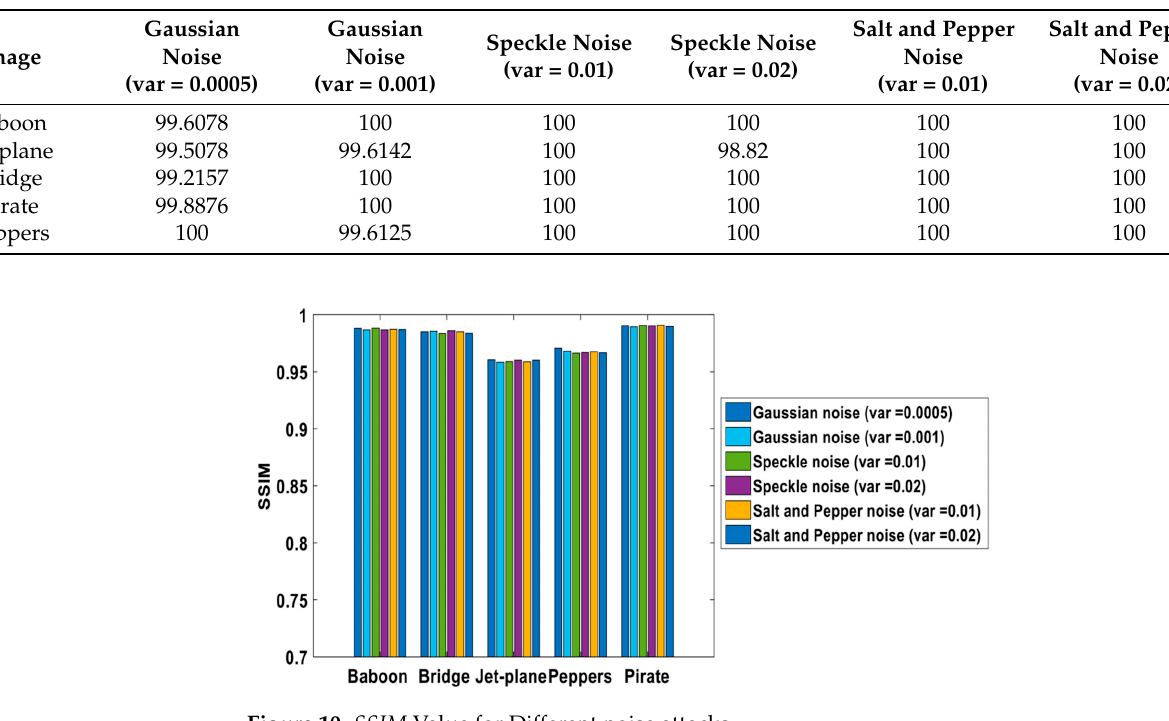
Figure 10. SSIM Value for Different noise attacks.